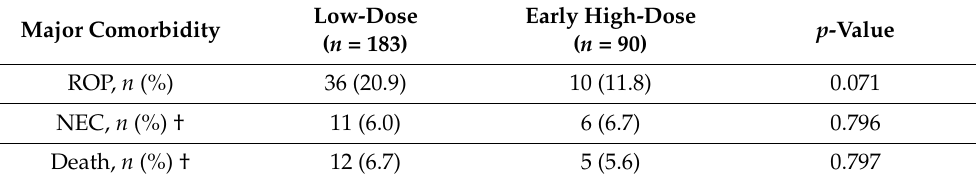
Table 4. Major comorbidities by caffeine group. Major